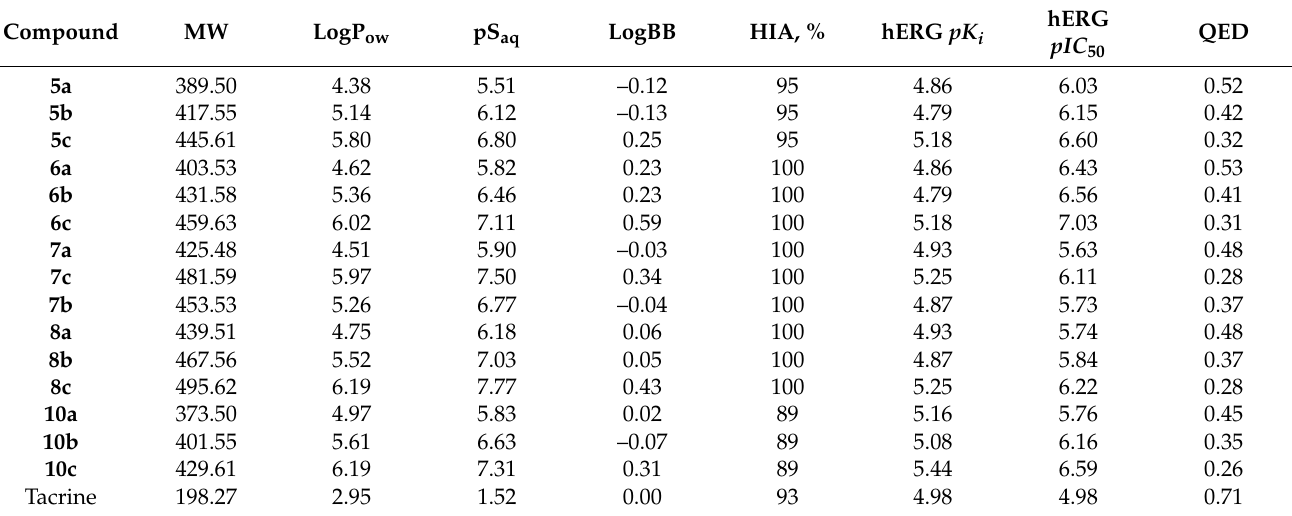
Table 7. Predicted ADMET and physicochemical profiles of compounds 5–8 and 10